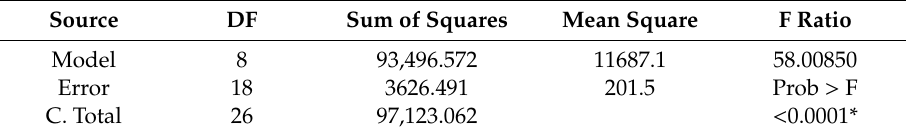
Table 9. ANOVA results for flow stress at 35% plastic strain ( α = 0.05).